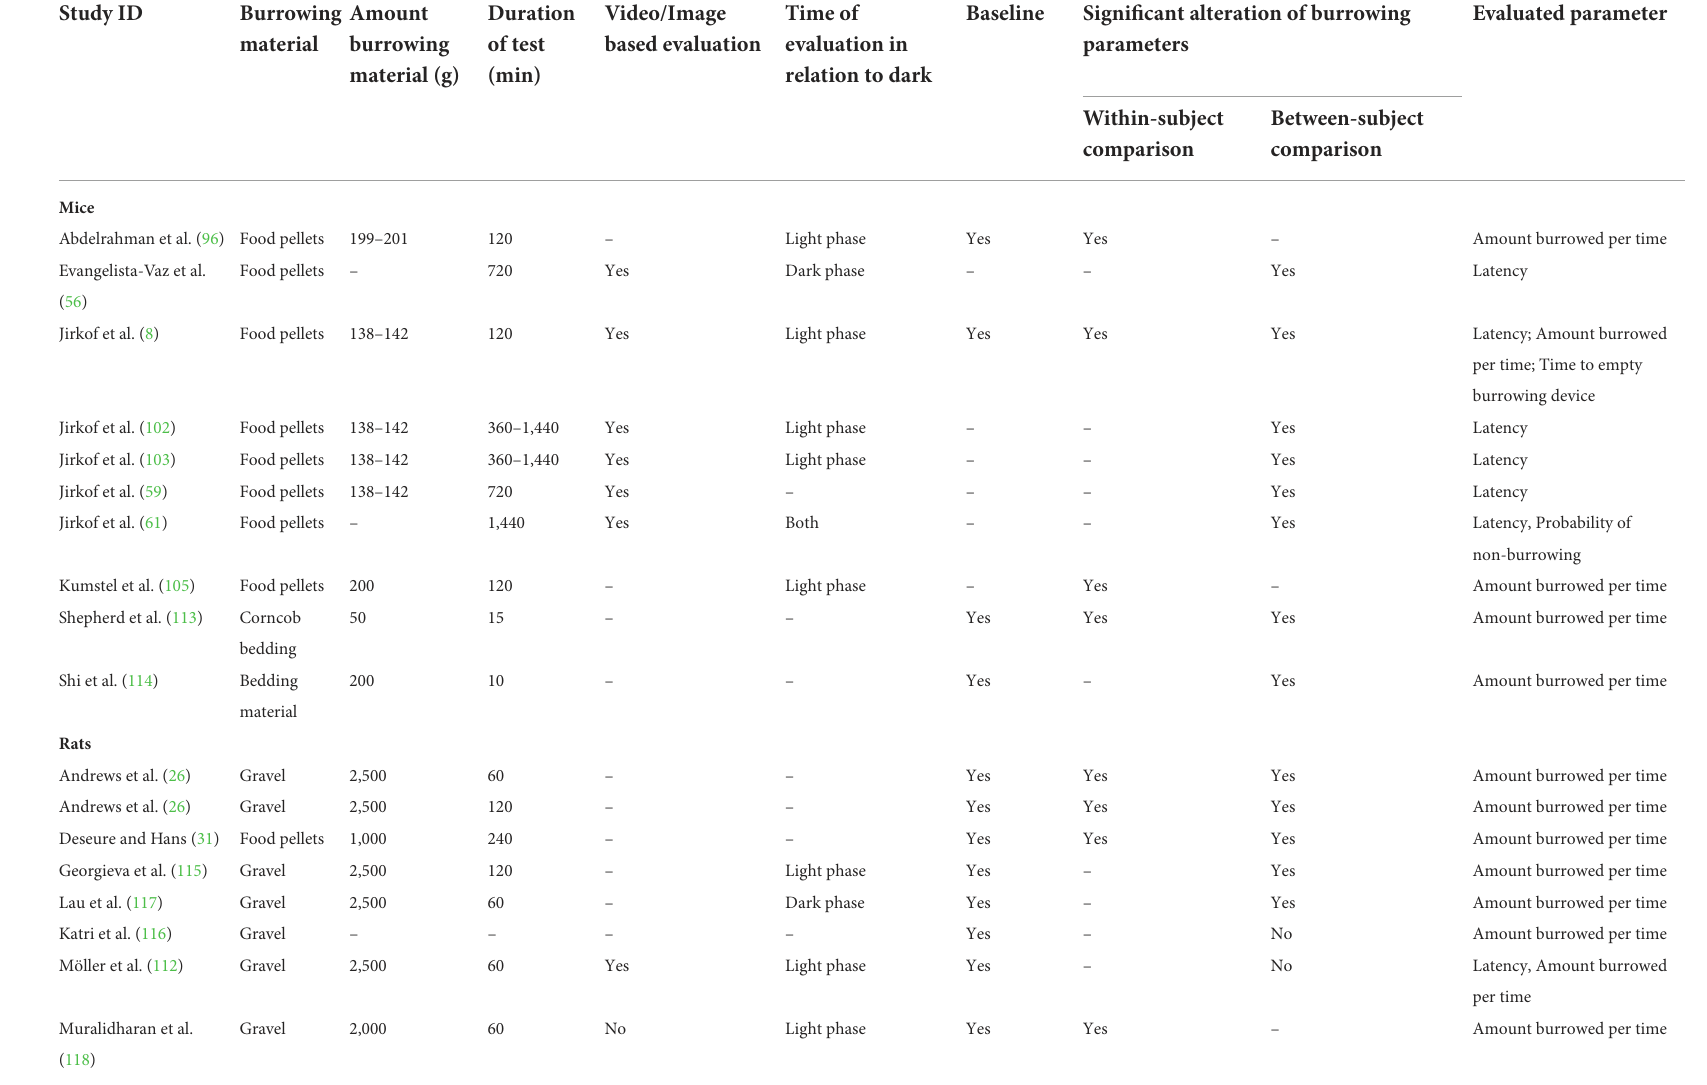
TABLE 9 Outcome characteristics for burrowing mice (k = 10 studies) and rats (k = 7 studies). Study